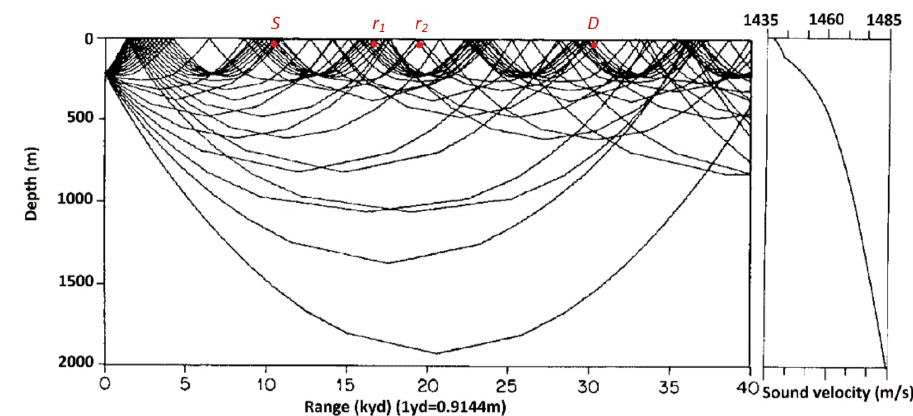
Figure 1. Test results of nonlinear sound ray propagation in the Arctic region, (Urick [40]).